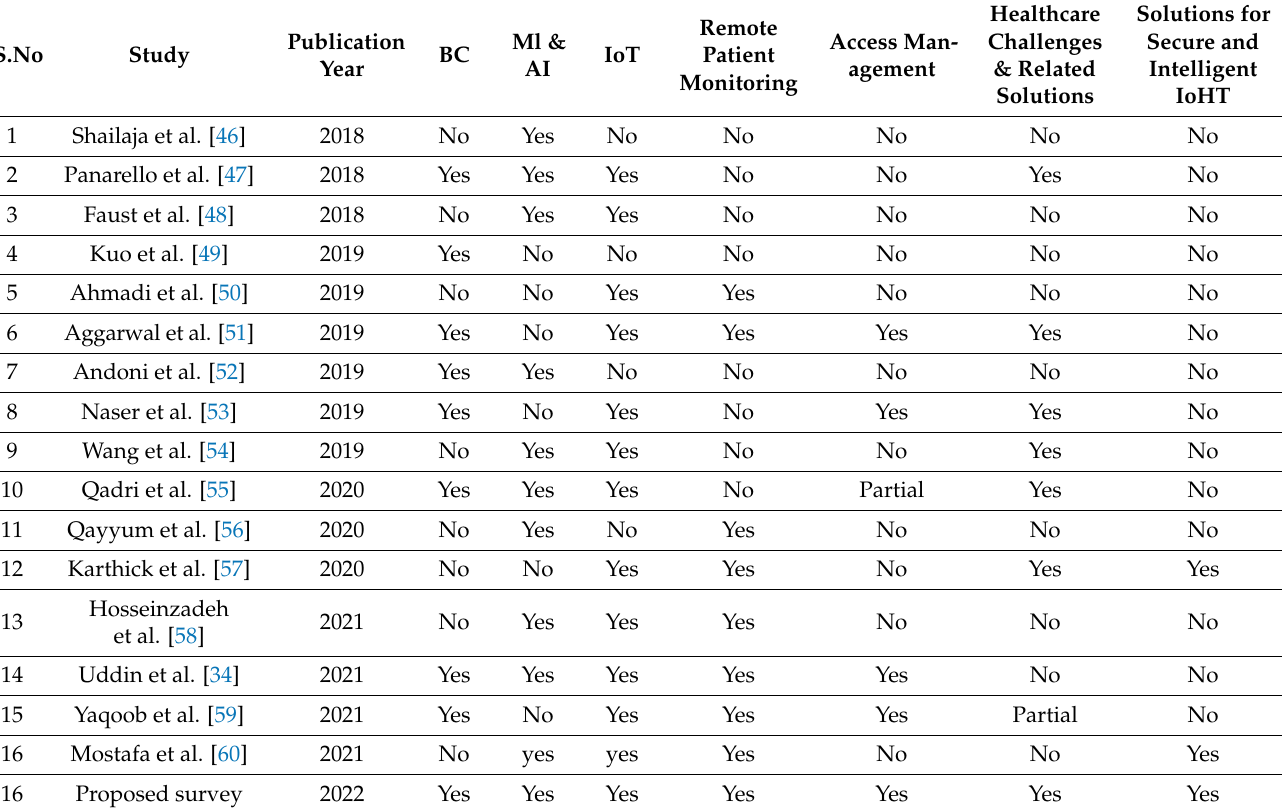
Table 1. Comparison of this study with existing survey